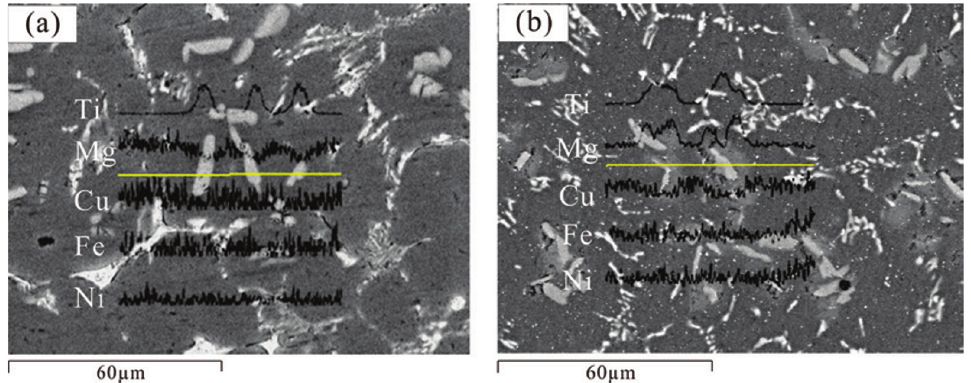
Fig. 3: Elements distribution around Al 3 Ti in (a) as-cast and (b) homogenized alloy 2618-Ti.